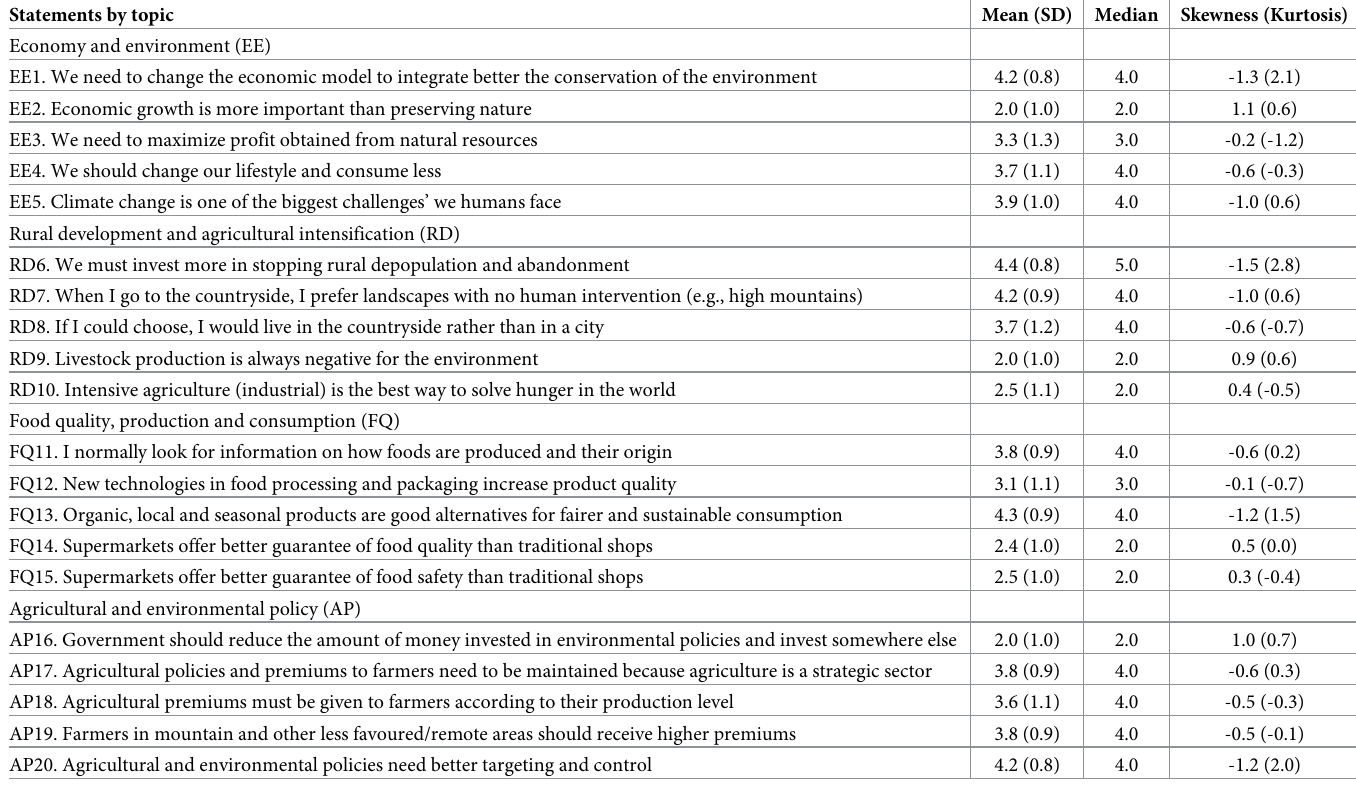
Table 1. Statements used in the questionnaire and descriptive